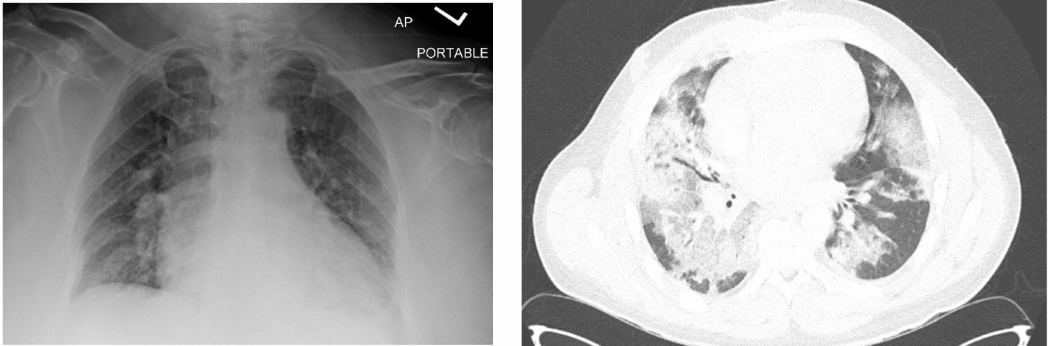
Figure 2. Chest radiograph ( left ) and axial image from chest CT ( right ) showing patchy opacifications on the day of